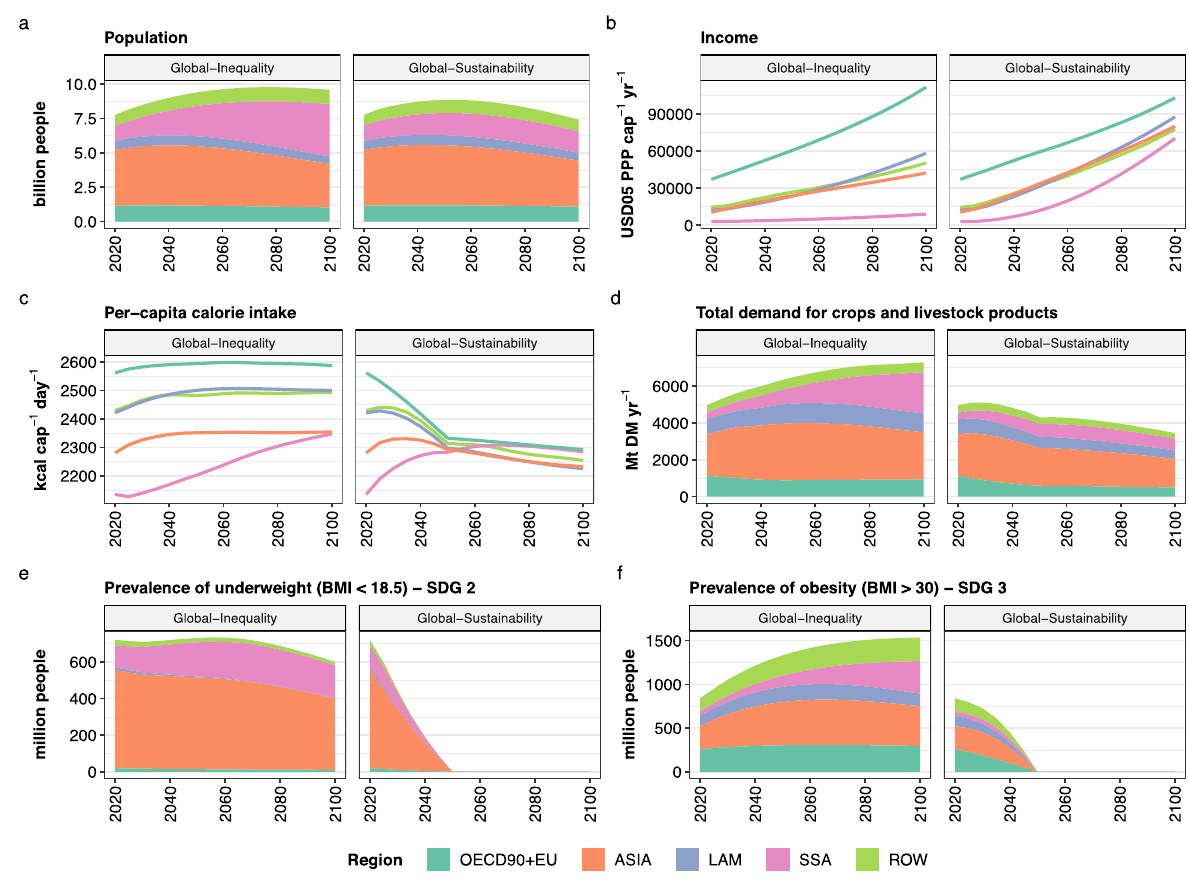
Fig. 1 | Key socio-economic drivers and developments. Data are shown at regional and global levels for the two main scenarios Global-Inequality (same for Global-GHGPriceandGlobal-EnvirProt)andGlobal-Sustainability(sameforGlobal- SustDemand). a population, b per-capitaincome, c per-capitacalorieintake, d total